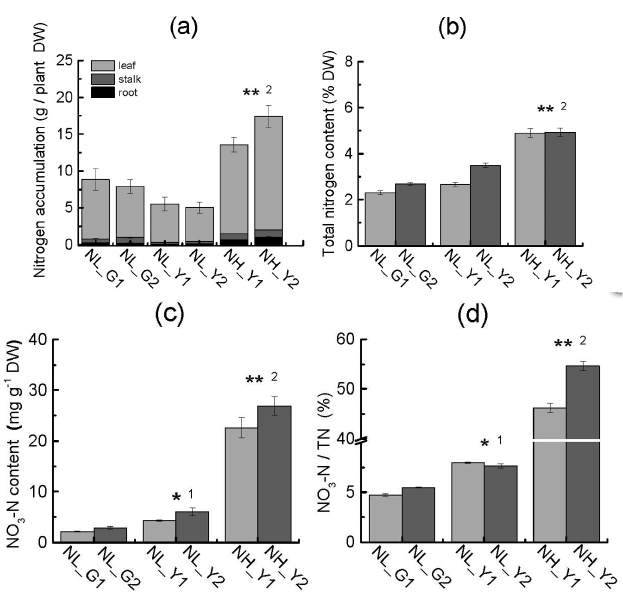
Figure 7. Differences in nitrogen compound between the two types at the same nitrogen level and same leaf biomass accumulation condition. ( a ) Nitrogen accumulation per plant; ( b ) Total nitrogen